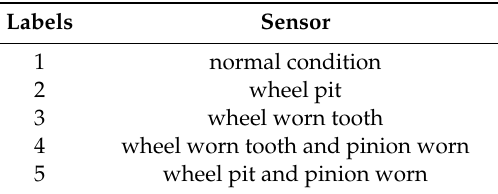
Table 3. Healthy states of the gearbox.